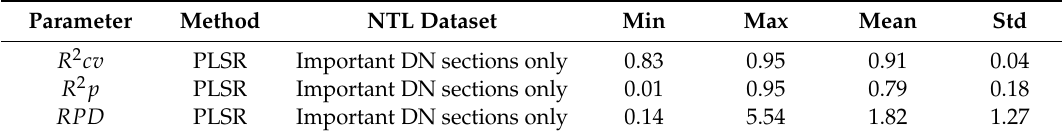
Table 3. Parameters for PLSR performance evaluation using important DN